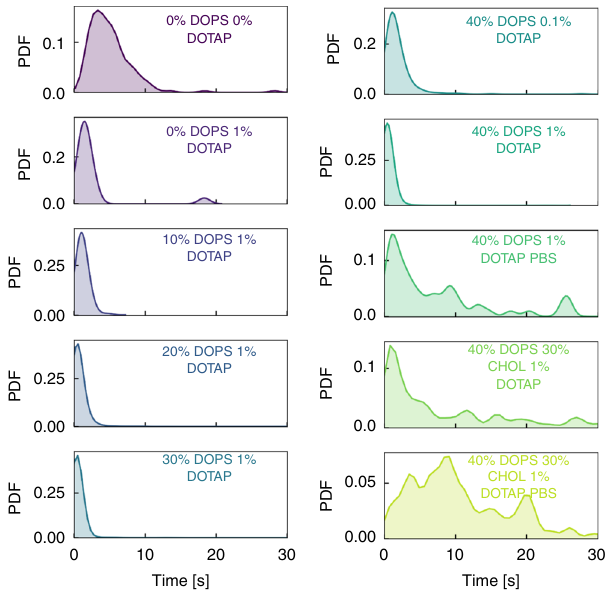
Fig. 4 Distribution of fusion times measured for varying bilayer and cubosome compositions. In each plot, the distribution is determined by at